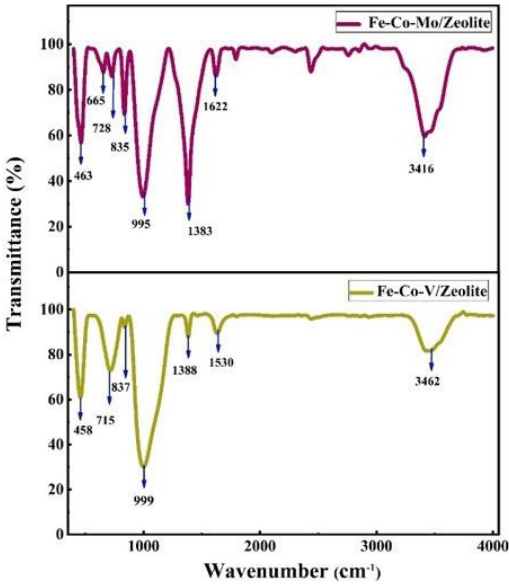
Figure 2. FT-IR spectra of Fe-Co-V/Zeolite and Fe-Co-Mo/Zeolite CNs. Table 1. Quantitative EDS analysis of Fe-Co-V/Zeolite and Fe-Co-Mo/Zeolite CNs.